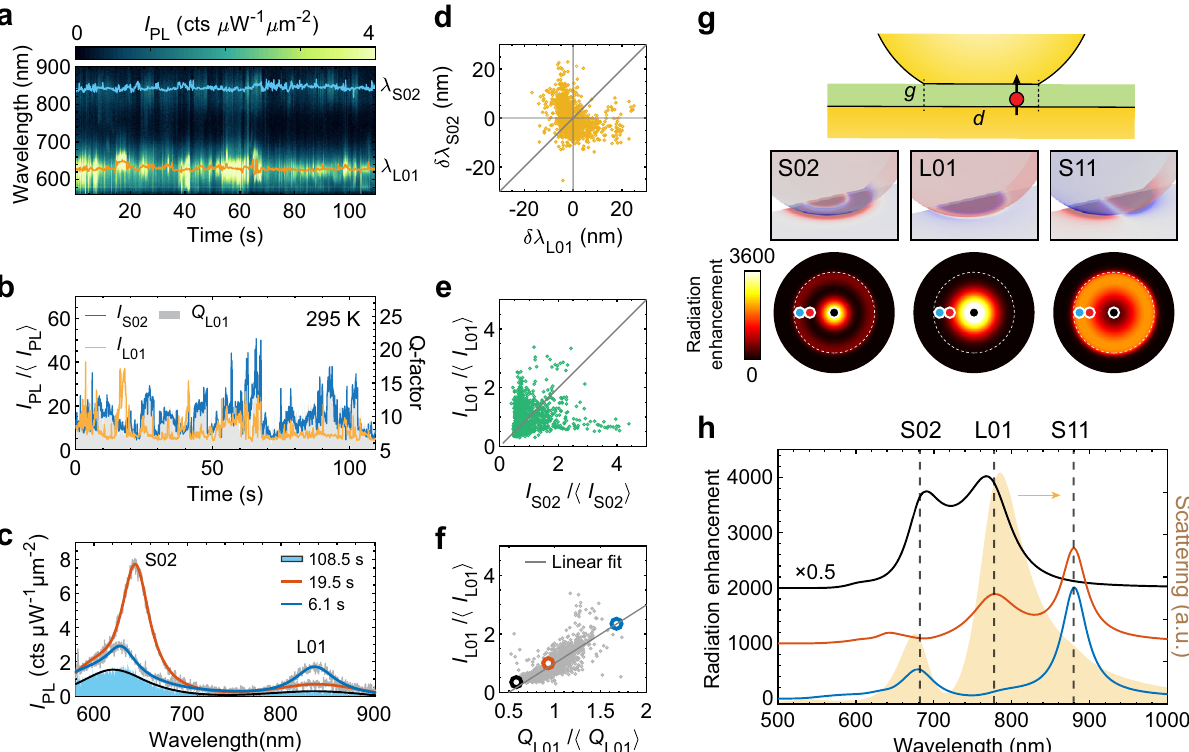
Fig. 2 Multi-mode blinking: evidence for spatially localized fl uctuating sources of emission. a Fluctuating PL time trace from a nanojunction emitting from the L01 and S02 gap modes. Excitation power density at 532 nm: ~45 μ W μ m − 2 , numerical aperture 0.85, exposure time: 0.1 s, room temperature. b Time series of peak PL intensities at the L01 (blue curve) and S02 (orange curve) resonances along with the Q factor of the L01 mode (gray-shaded area). c Examples of PL spectra with different Q factors (as fi tted by Lorentzian functions), along with the typical baseline PL spectrum (blue-shaded area). d , e Distribution of the PL peak wavelength ( d ) and intensity ( e ) (relative to their time average denoted by brackets) around one resonance vs. the other, showing no correlations. f Distribution of relative PL intensity vs. Q factor for the L01 emission, showing a positive correlation. Individual spectra from c are highlighted with black, red, and blue circles. g , h Full-wave simulation ( fi nite-element modeling) of the optical response of a faceted nanojunction. g Based on the surface charge distributions taken at resonance, the modes are identi fi ed as the lowest frequency Fabry – Perot-like transverse cavity mode S11, the dipolar bonding antenna mode L01, and the higher-order cavity mode S02, respectively 50 . These modes feature distinct spatial distributions of their local photonic density of states (PDOS), which result in different far- fi eld emission spectra (solid lines in h , offset for clarity) when a radiating point dipole is placed at the different locations shown by color-coded full circles in g . The yellow-shaded area in h corresponds to the calculated DF